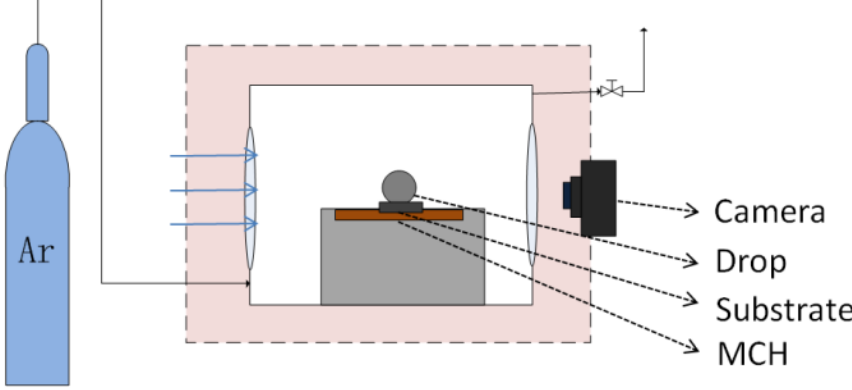
Figure 2. The schematic of the contact angle measuring device [24].